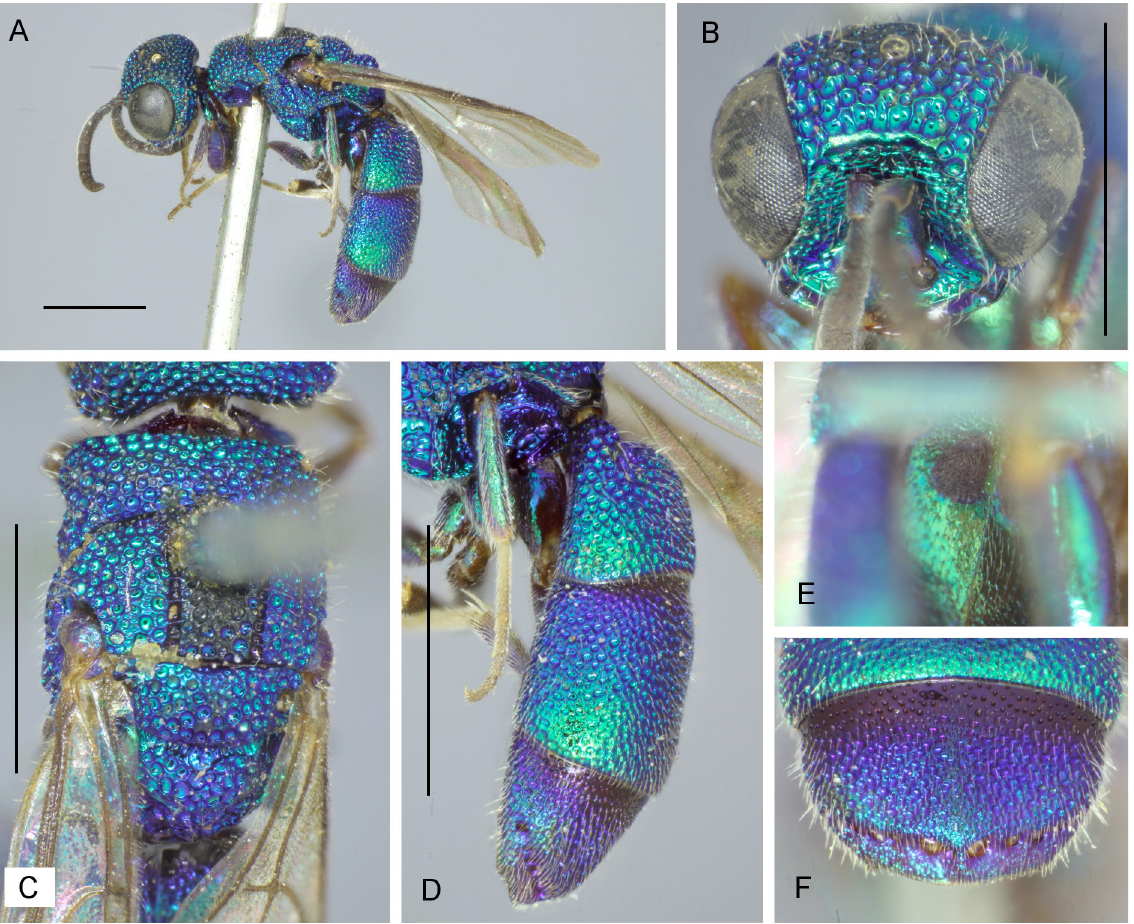
Fig. 4. Chrysidea vazimba sp. nov., paratype, ♂. A . Lateral habitus. B . Head. C . Mesosoma. D . Metasoma. E . Black spots on S2. F . T3. Scale bars = 1.0